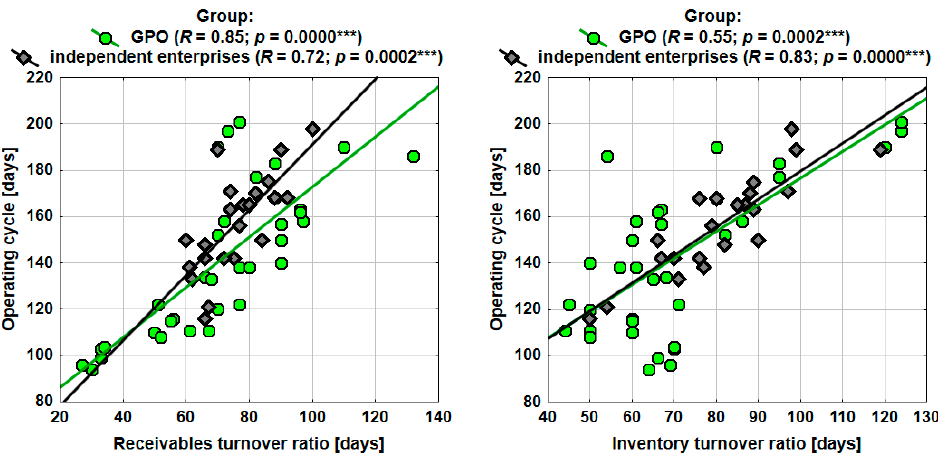
Figure 3. Scatter chart of receivables and inventory turnover cycles. Source: author’s calculations and studies.